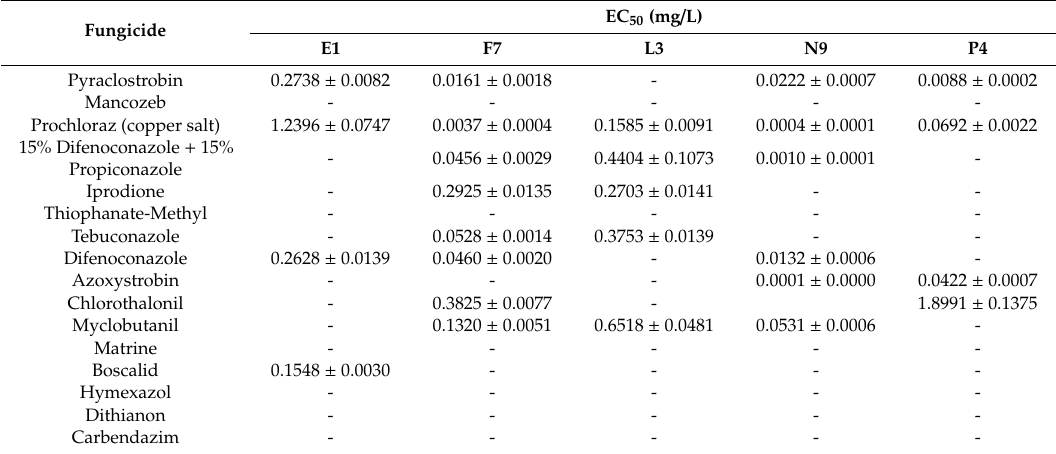
Table 4. EC 50 of 16 fungicides against the five identified pathogens.